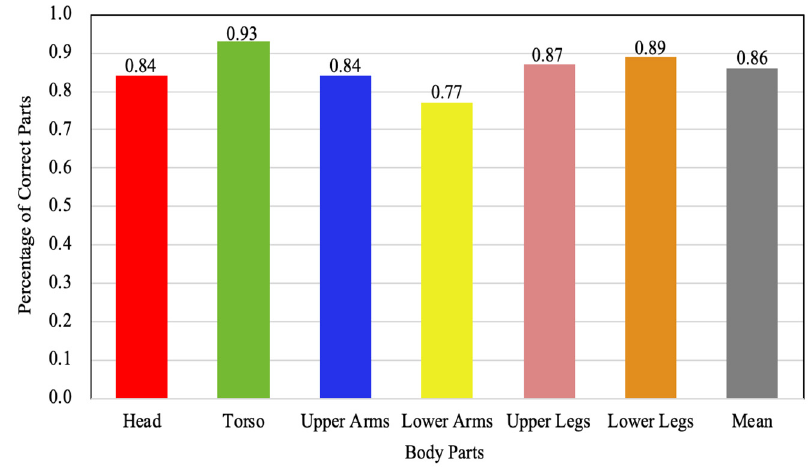
Figure 9. The mean PCPs of each body part.